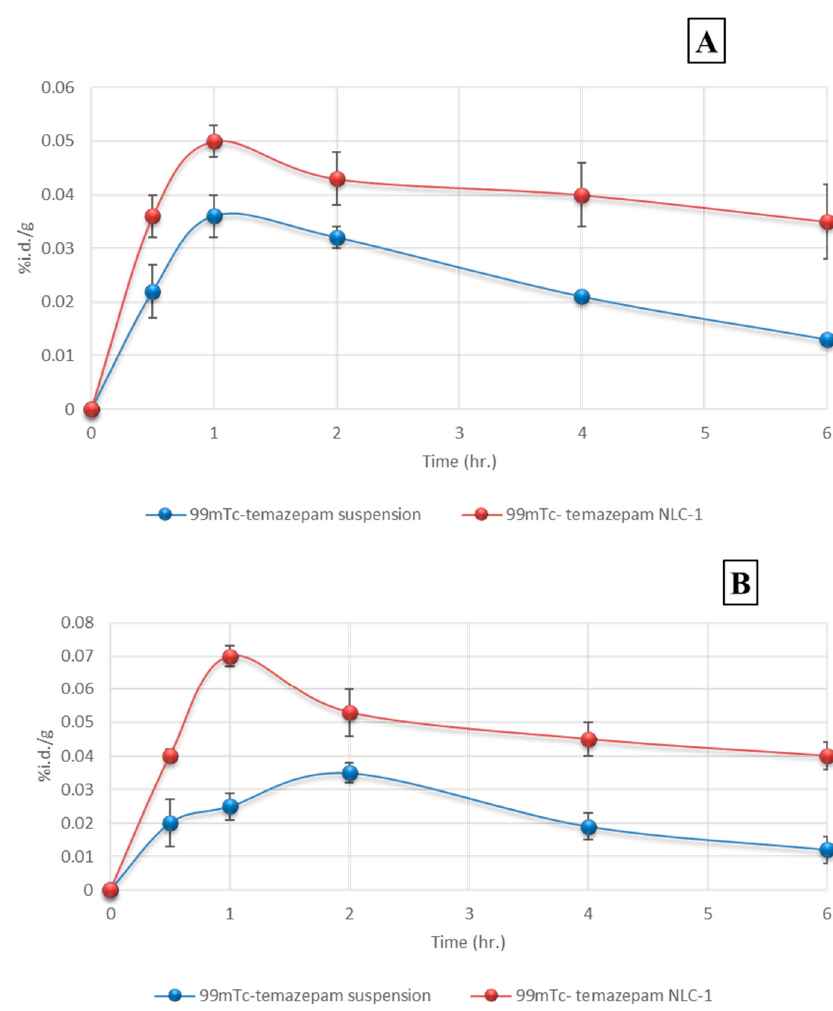
Figure 12. Concentration–time profiles of 99m Tc-temazepam suspension and 99m Tc-temazepam NLC-1 formulation after oral administration to rats. Panel ( A ) Plasma; and panel ( B ) brain. Each data point represents the mean ± SD of six determinations.